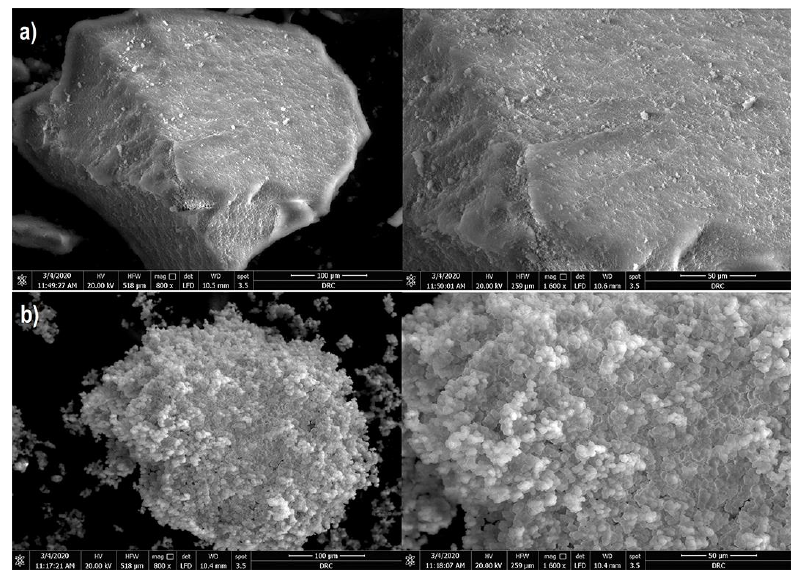
Fig. 4. Scanning electron microscope images of (a) non-imprinted polymer (NIP), and (b) azoxystrobin molecularly imprinted polymer (AZX-MIP) show the arrangement of polymer around the cavity for AZX binding in MIP, however, no cavities on the surface of NIP.